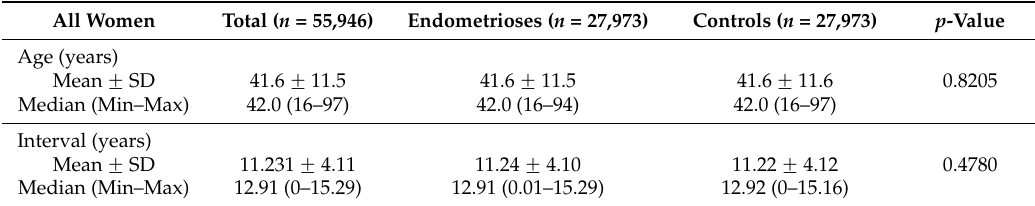
Table 6. Age and surveillance time between enrollment in the cohort and the end of the last